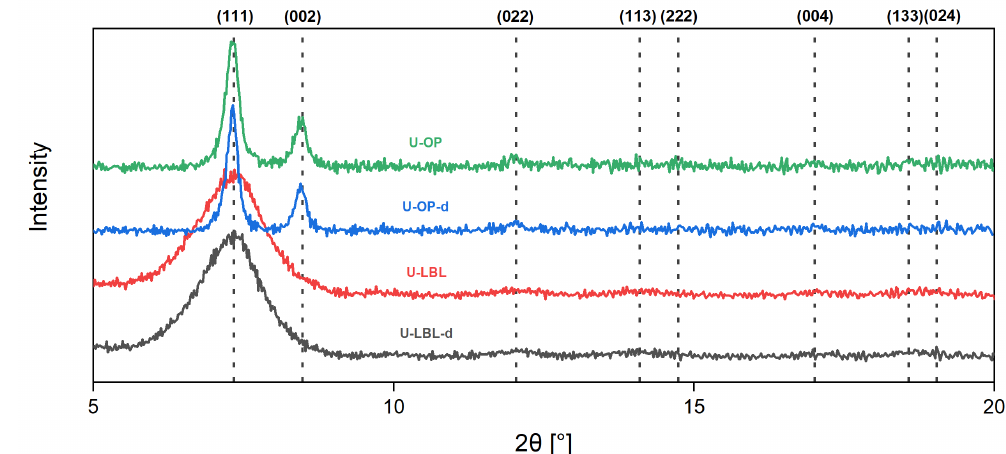
Figure 3. Normalized diffractograms of the four UiO-66-NH 2 membranes. The plots of U-LBL and U-LBL-d have been recently published elsewhere [35].